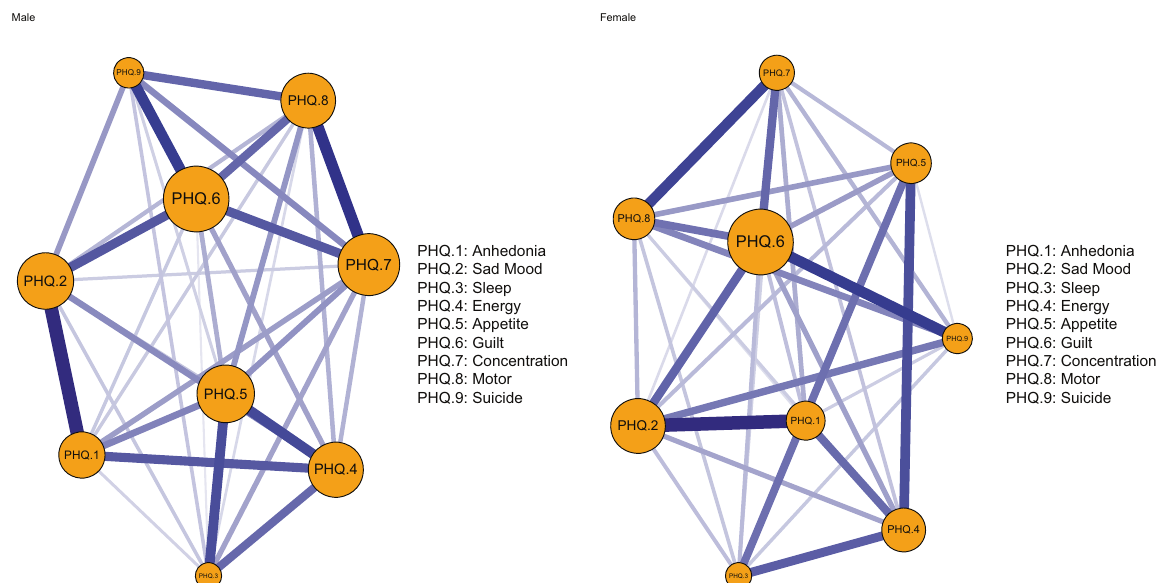
Fig. 5 Estimated network models for dichotomized depressive symptoms in male and female participants. Left panel: network structure in male participants ( n = 2 105); Right panel: network structure in female participants ( n = 8